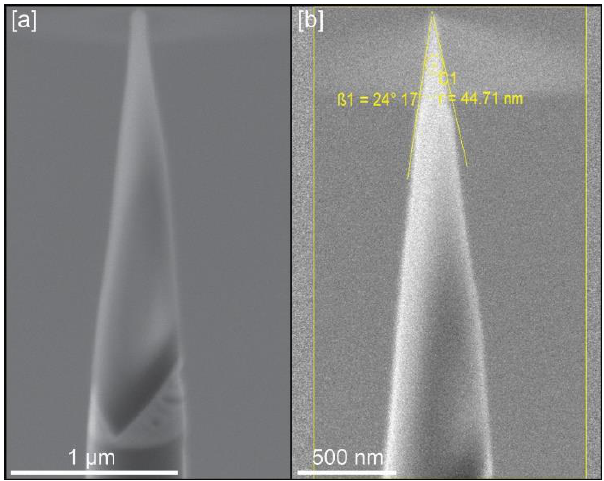
Figure 3. Example of tips for LEAP analysis: ( a ) Tip geometry after initial sharpening; ( b ) Tip geometry and dimensions (radius and shank angle) after final cleaning at 5 kV.